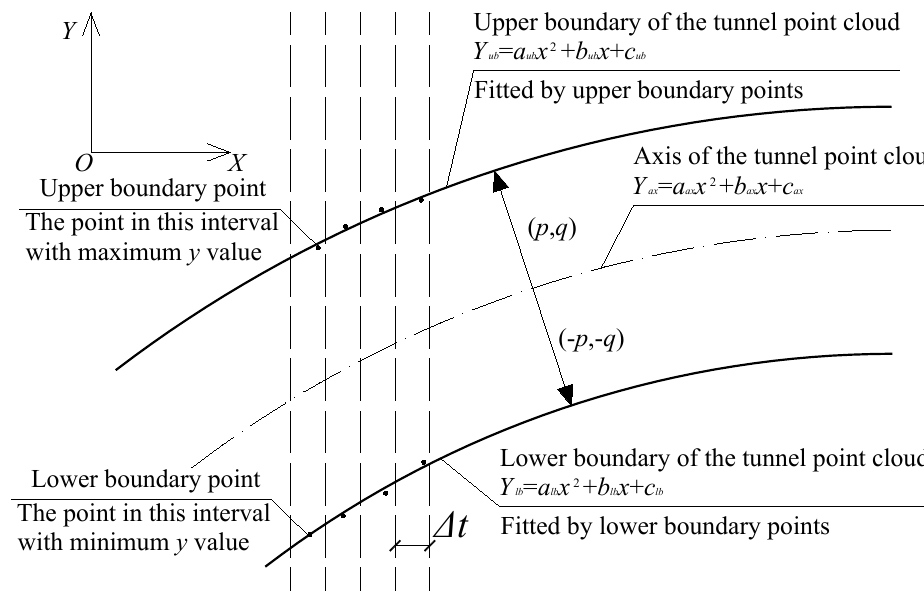
Figure 3. The intuitive figure of the acquisition of the circular tunnel